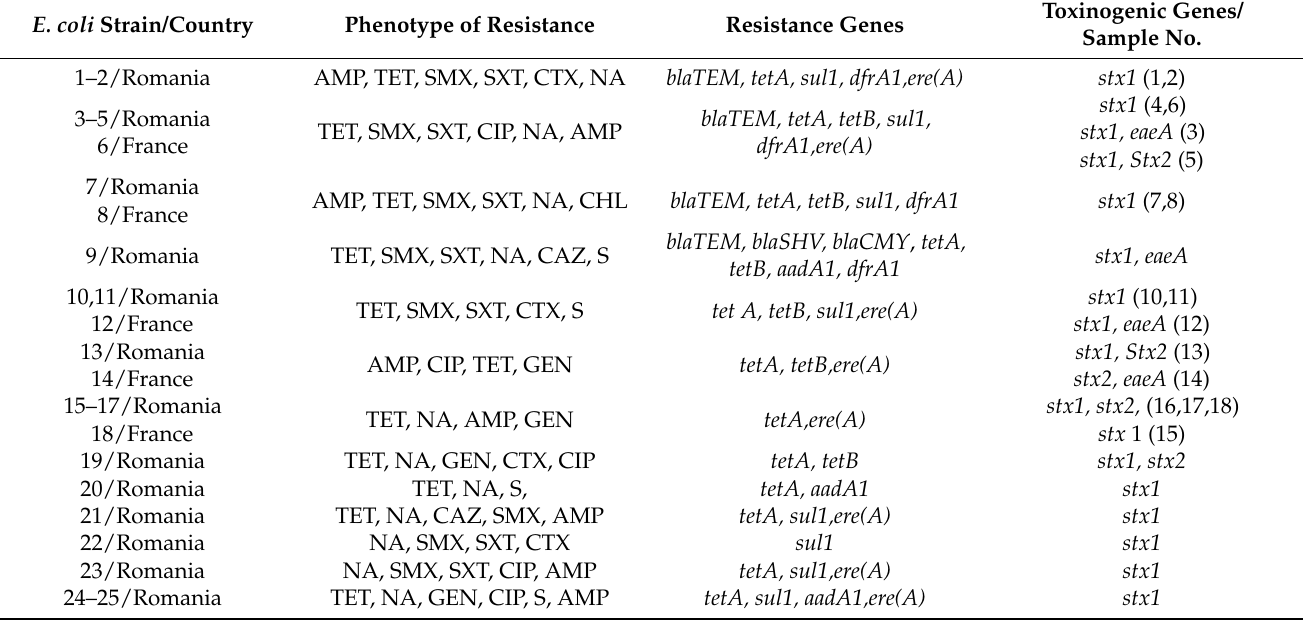
Table 2. MDR E. coli phenotypes and their mechanism of resistance in pathogenic strains isolated in Romania and France.